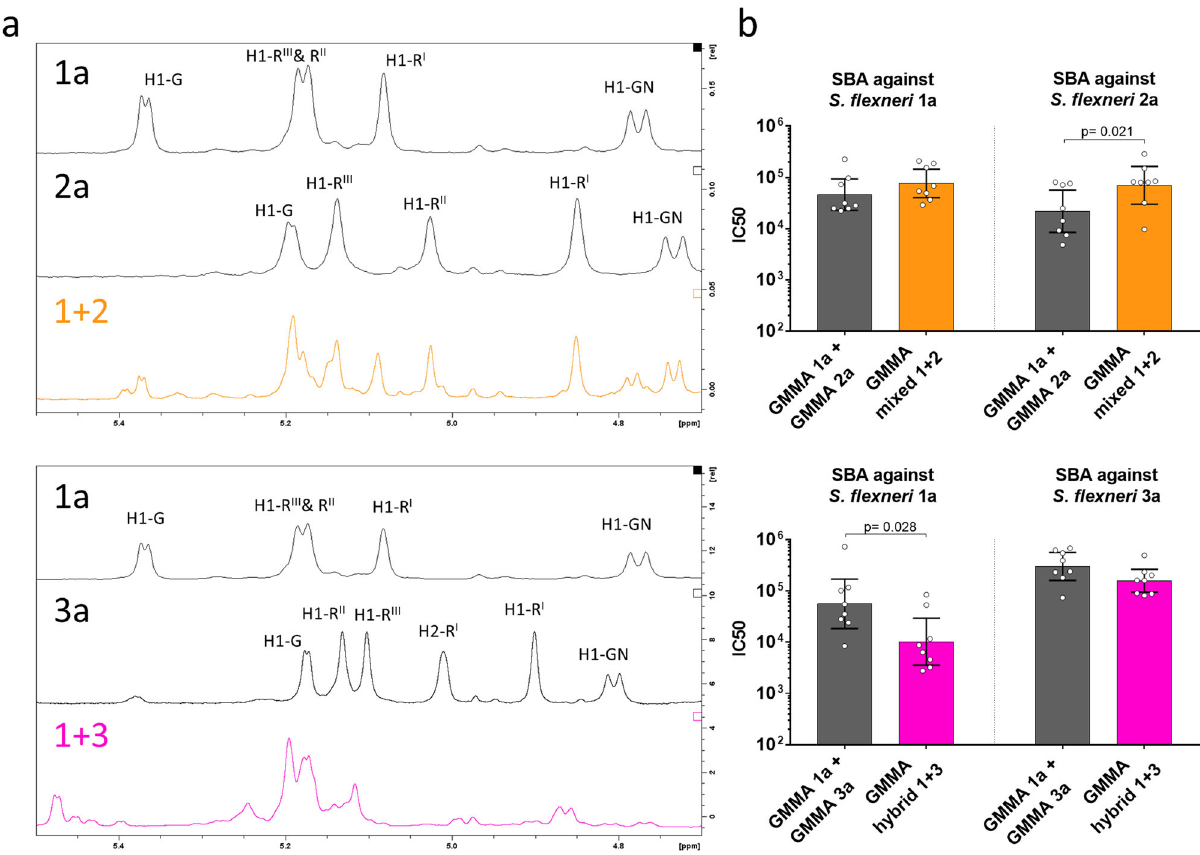
Fig. 4 Characterization and immunogenicity of GMMA displaying mixed or hybrid serotypes. a Anomeric region of 1 H-NMR spectra of OAg isolated from GMMA (R = Rhamnose; GN = N-Acetyl Gucosamine; G = Glucose). Mixed or hybrid serotypes were compared to the corresponding individual serotypes. b Bactericidal activity of sera raised in mice by GMMA displaying mixed or hybrid serotypes compared to physical mixtures of GMMA displaying the corresponding individual serotypes. Serum dilutions able to kill 50% of bacteria in the assay (IC 50 ) are reported for individual mice (dots), error bars represent 95% con fi dence